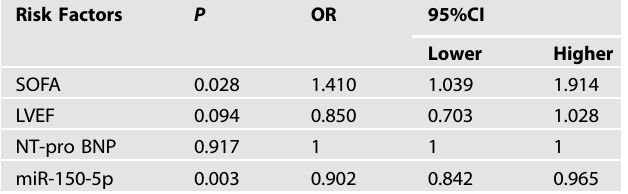
Table 3. Multivariable logistic regression of SIC.